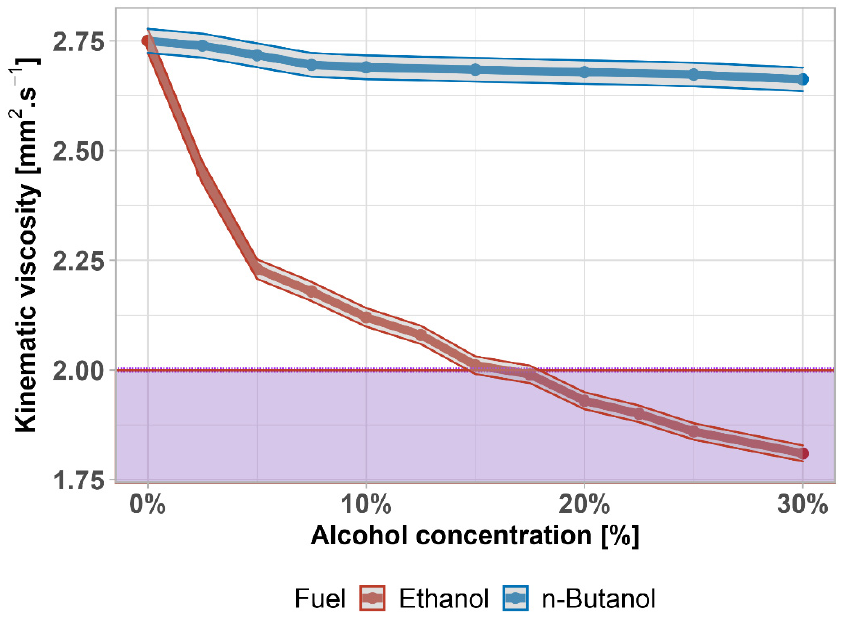
Figure 7. Kinematic viscosity of diesel fuel–alcohol mixtures. Purple area highlights exceeding the limit given by the standard.